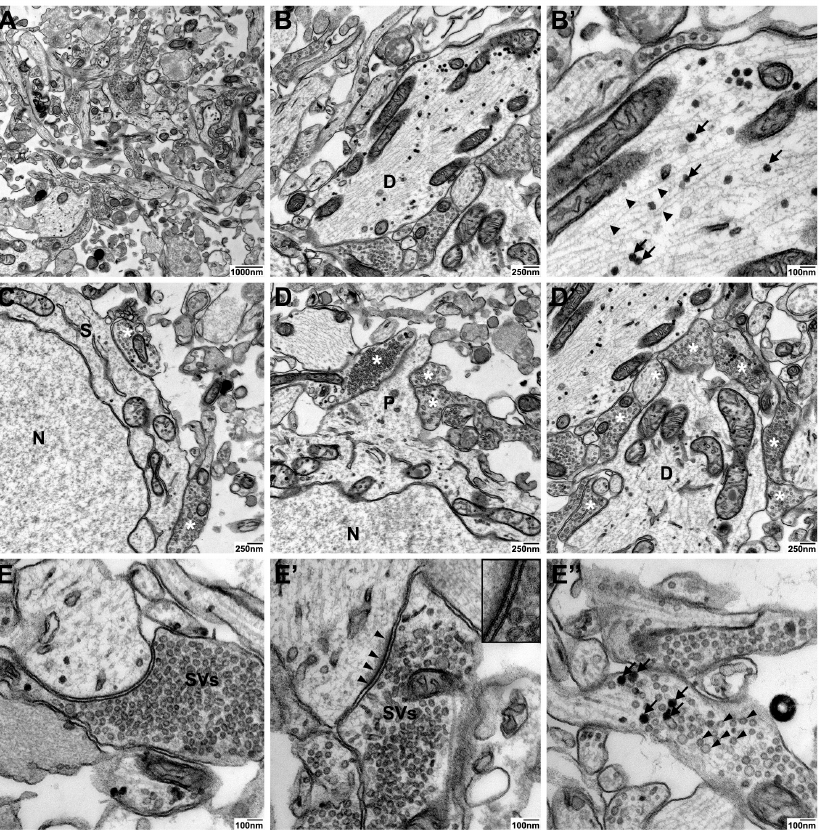
Figure 5. High contrast en-bloc staining protocol o ff ers high-quality ultrastructural preservation and optimal membrane visualization in cultures neurospheres: Synapses. Transmission electron micrographs from cultured iNSC-derived neurospheres prepared using high contrast electron microscopic staining (high contrast en-bloc stain). Overview of neuronal processes ( A ). Single neuronal process (dendrite, D ) at lower ( B ) and higher magnification ( B’ ) showing neurofilaments (arrowheads) and dense core vesicles (arrow) with optimal preservation of cellular membranes. Axosomatic synapses ( C ) and axodendritic synapses ( D , D ’); presynaptic compartments. Examples of individual synapses ( E – E ’) showing optimal preservation of pre- and postsynaptic membranes, small synaptic cleft, postsynaptic density ( E ’, arrowheads), and synaptic vesicles (SVs). Enlarged view of the boxed region in E’ showing optimal preservation and staining of the lipid bilayers of pre- and postsynaptic membranes. Di ff erent types of synaptic vesicles could clearly be distinguished in neuronal processes showing clear (arrowheads) and dense core (arrows) vesicles ( E ”). N: nucleus, S: soma, P: process. Scale bars as